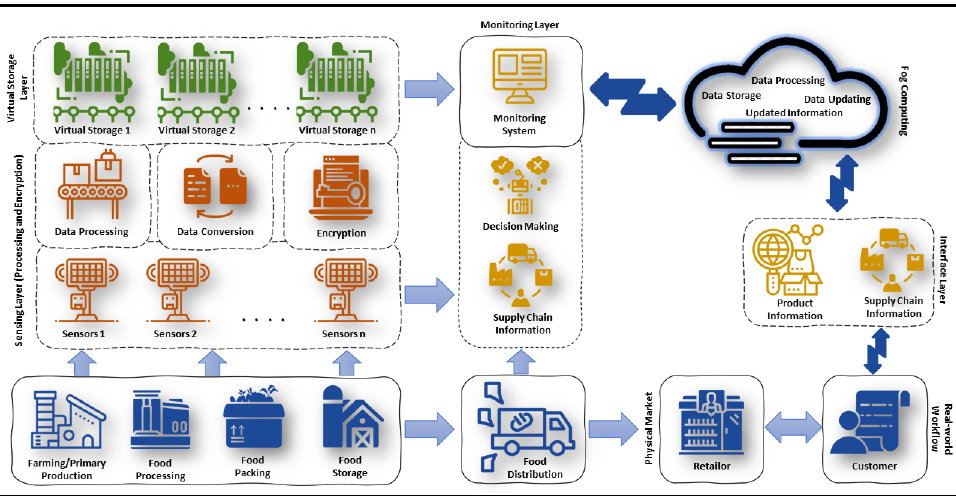
Figure 1. The proposed cps-based food traceability